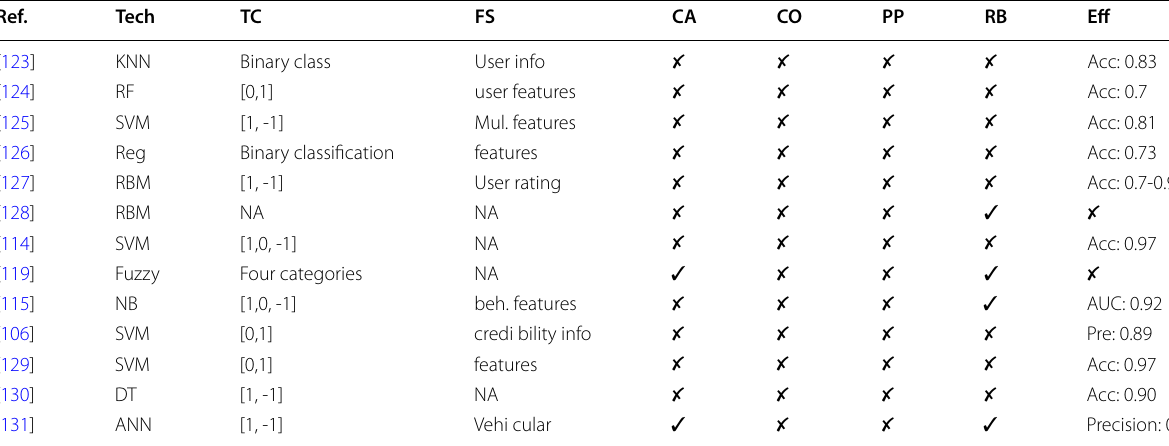
Table 4 Comparative Analysis of AI Trust-Based Models